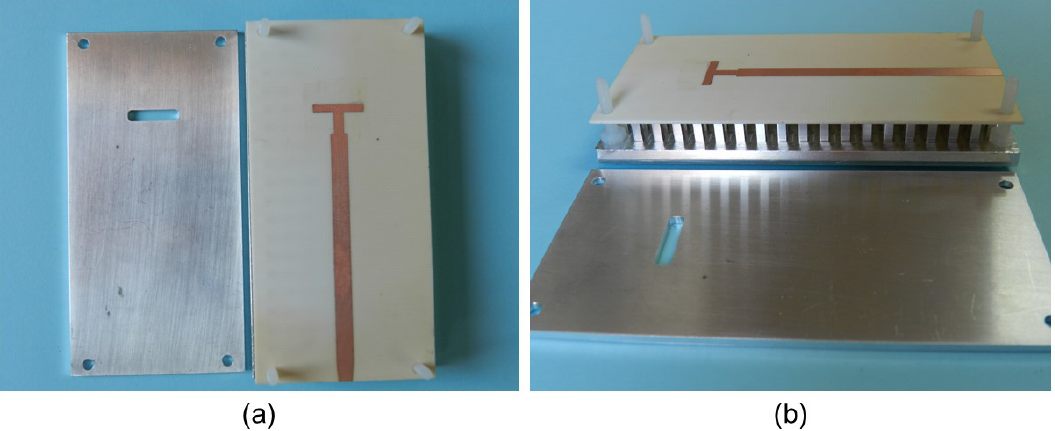
Figure 17. Photograph of the fabricated slot reference antenna: ( a ) Front view of the slot layer and the microstrip feeding line with the T-shape feeding line section. ( b ) Side view of the GWG antenna with the top cover plate removed.